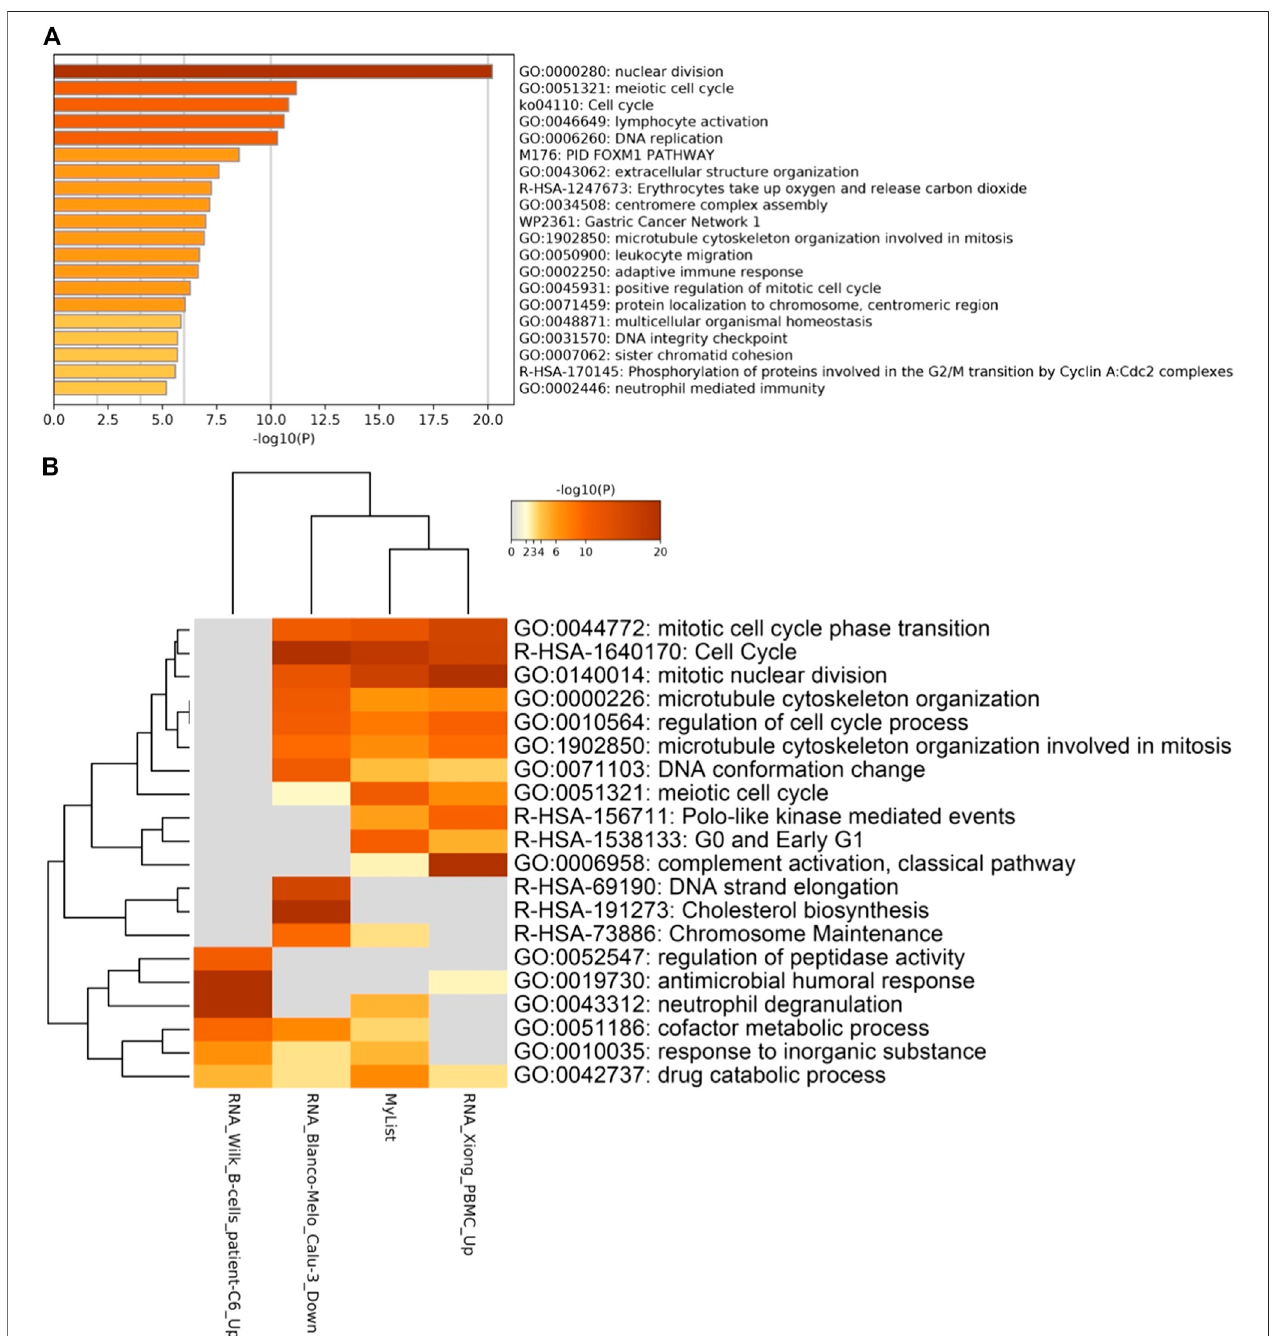
FIGURE 17 | (A) enrichment analysis for the 387 ventilation only genes reveal most genes are involved in nuclear cell division. And (B) COVID-19 lists reveal that most genes are involved in the immune system.